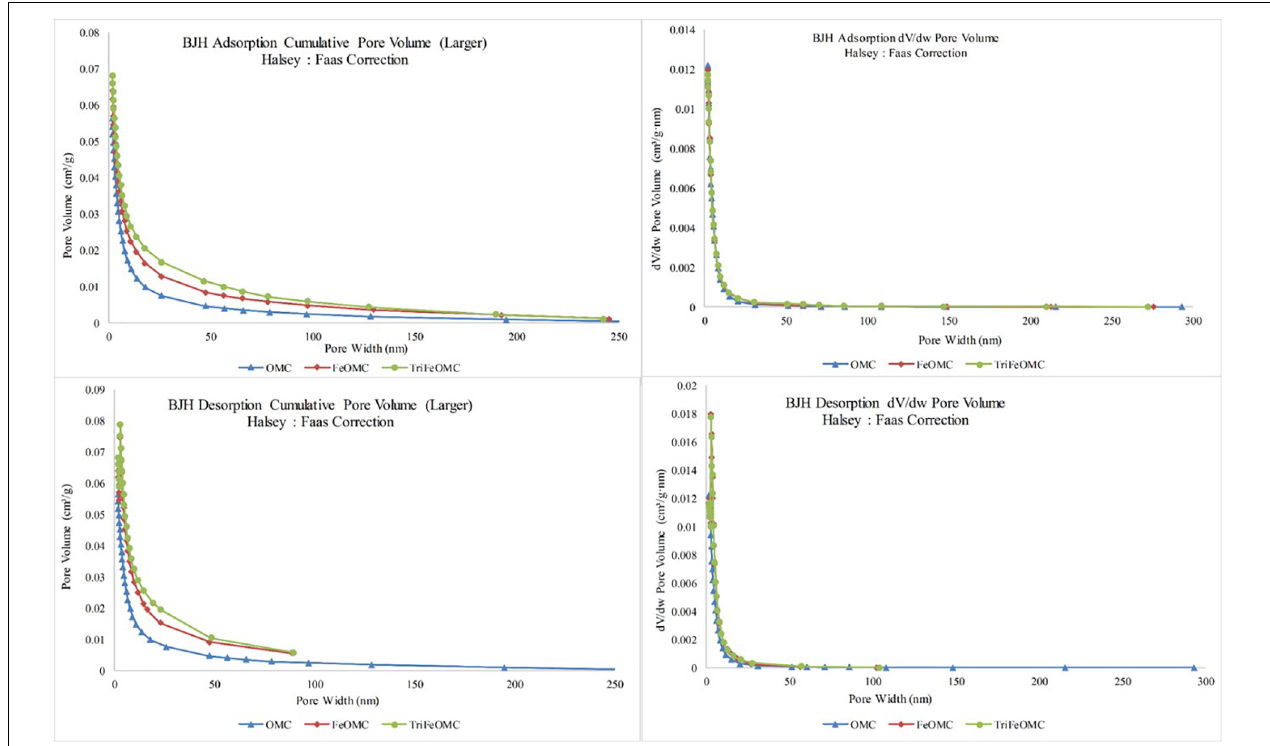
FIGURE 4 | The pore volume and pore width comparisons for adsorption and desorption of OMC, FeOMC, and TriFeOMC.